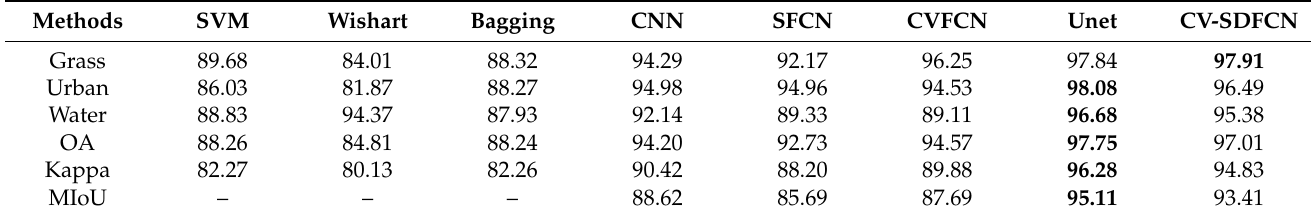
Table 1. Classification accuracy of Xi’an dataset ( % ) .